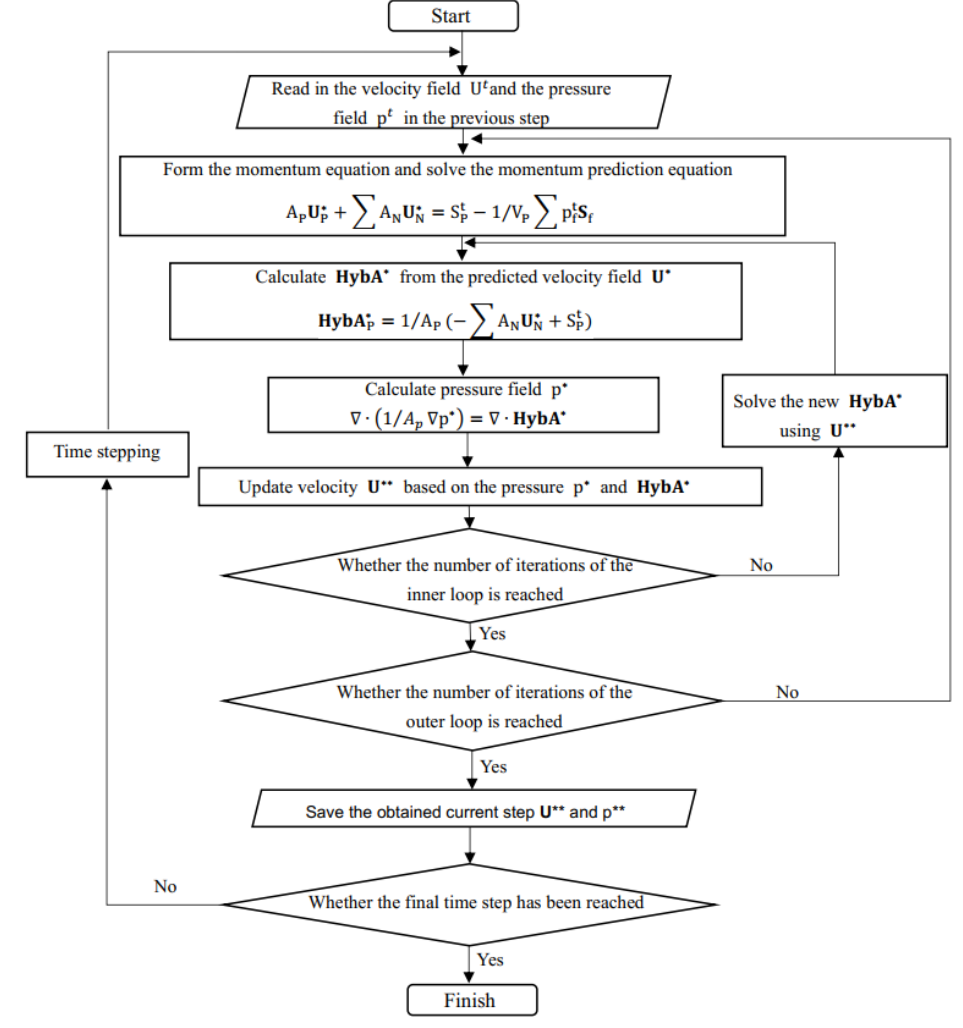
Figure 5. The basic steps of the PIMPLE algorithm solution.( The superscript * represents the prediction step (to be determined))